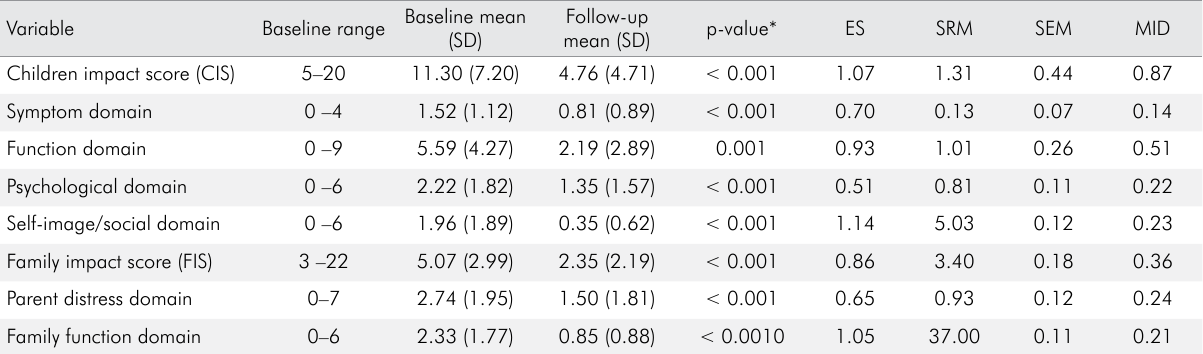
Table 2. Mean change in scores for total scores and individual domains of the B-ECOHIS scores before and after treatment (n = 27).